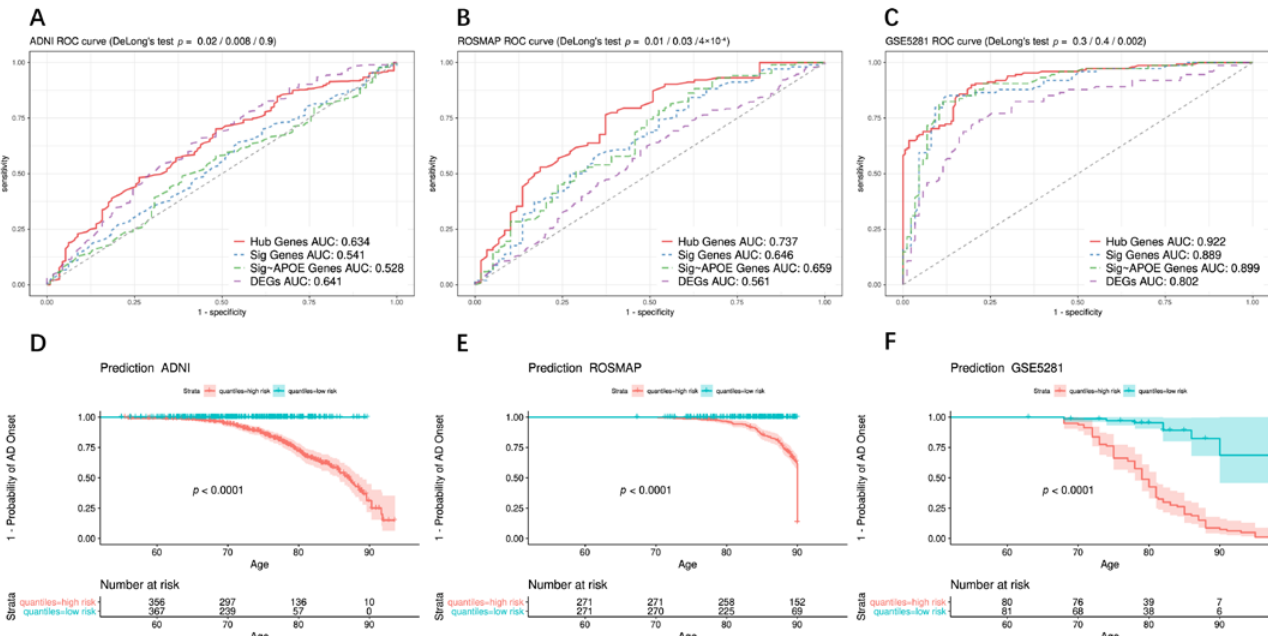
Figure 4. Construction and evaluation of AD predictive models in different independent datasets (ADNI, ROSMAP, GSE5281). Random forest algorithm was applied on the three different cohorts to establish AD predictive models through 10-fold CV (ADNI ( A ), ROSMAP ( B ), GSE5281 ( C )). DeLong’s tests were used to compare the difference between ROC curves. Kaplan–Meier survival curves were used to estimate the accuracy of the hub genes signature on predicting survival. Individuals were well stratified by their risk predictions, and individuals in the high-risk group had a significantly earlier age of AD onset, as found for all ADNI ( D ), ROSMAP ( E ), GSE5281 ( F ) datasets (Log-rank test, p < 0.0001).